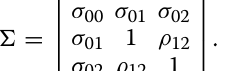
Table 2 Root of the mean squared error (RMSE) for three cases of simulation with the normality assumption